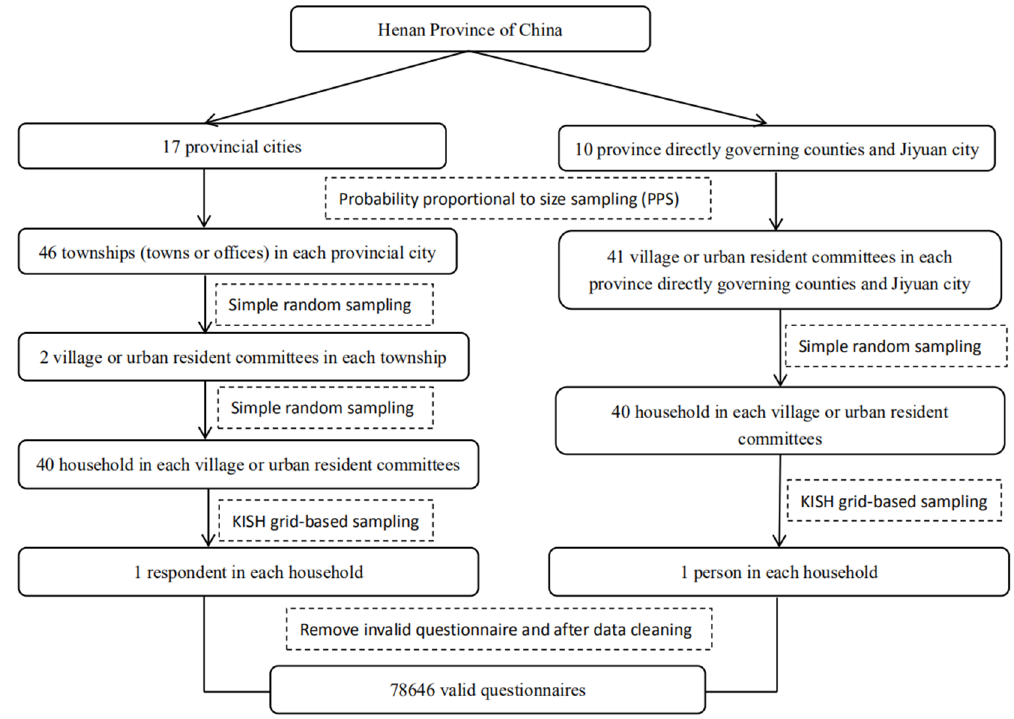
Figure 1. Flow chart for participants sampling in the study on health literacy in a 15 to 69-year-old population, Henan, China, 2016.